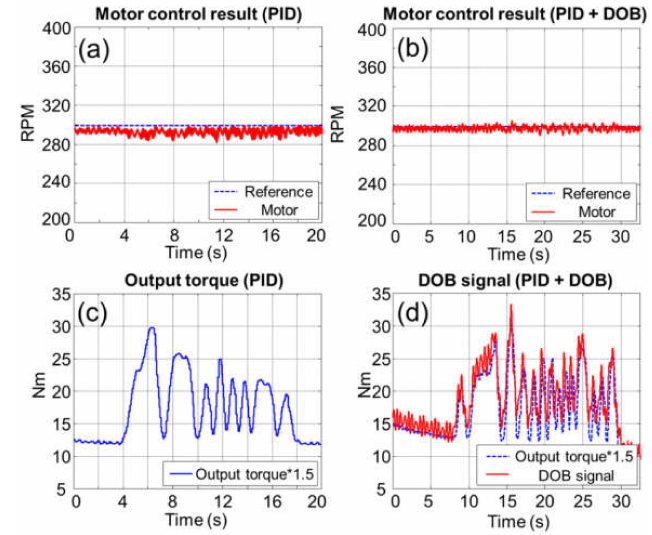
Figure 12. Speed tracking performance of: ( a ) PID controller; ( b ) Disturbance Observer (DOB) + PID controller; ( c ) Output torque; ( d ) Output torque estimation by